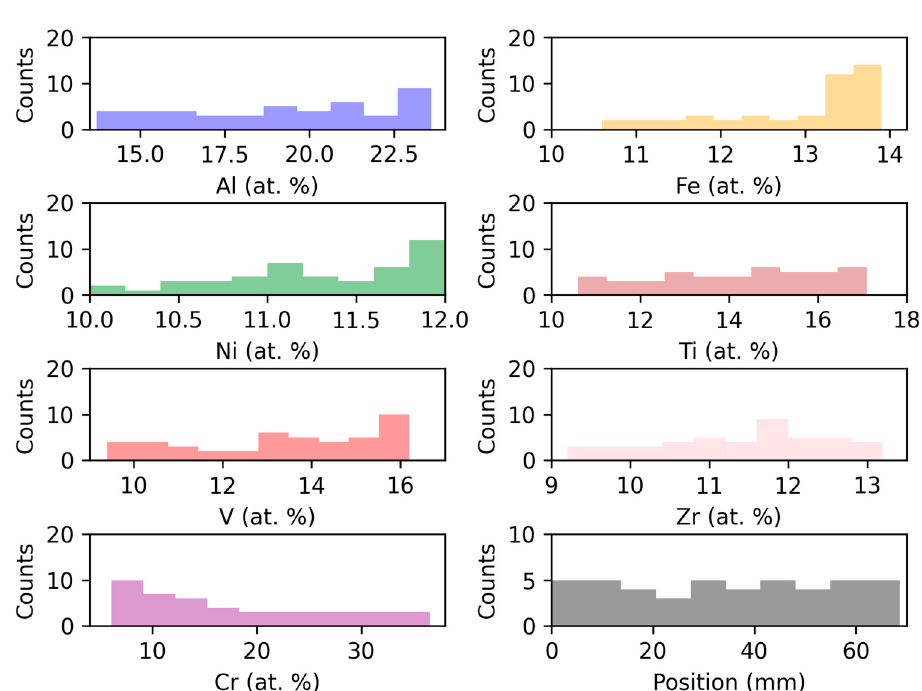
Figure 2. Attribute distribution in the Ruiz-Yi et al. dataset [1].